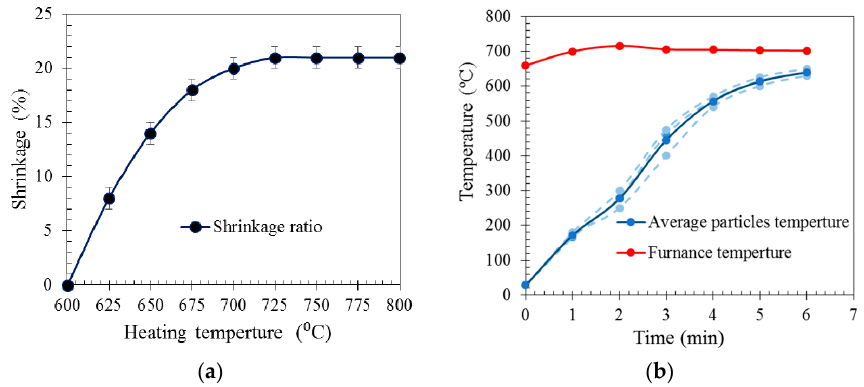
Figure 3. ( a ) Shrinkage ratio of EG particles for 20 min heating time at different furnace temperatures; and ( b ) the core temperature of the EG particle bed during heating.